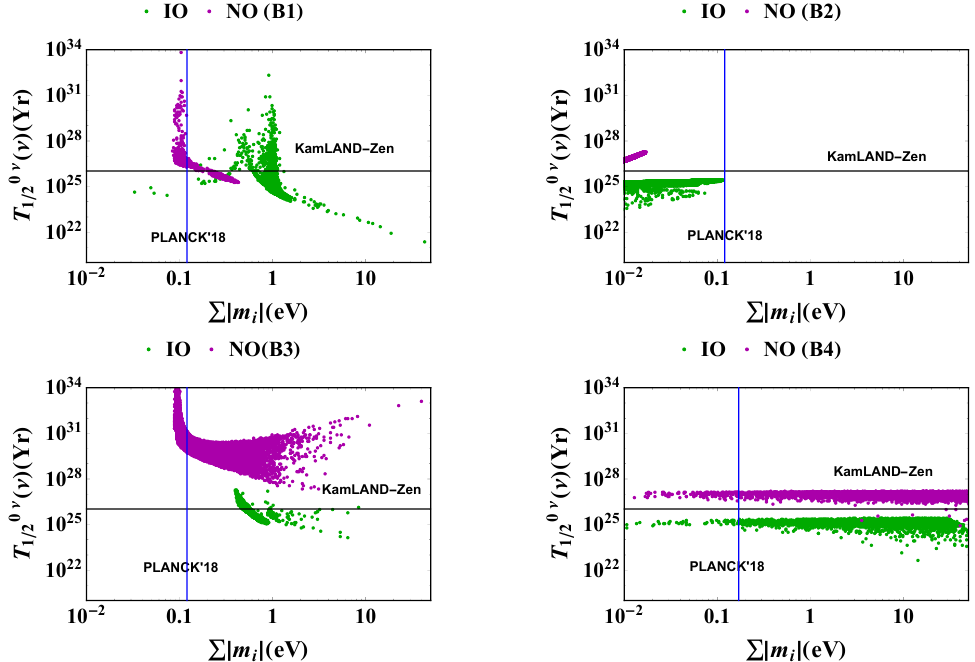
Figure 8 . Light neutrino contribution to half-life governing NDBD as a function of the sum of light neutrino mass. The solid blue (vertical) and black (horizontal) line represents the Planck upper bound of sum of absolute neutrino mass and the KamLAND-Zen lower limit on half-life respectively.